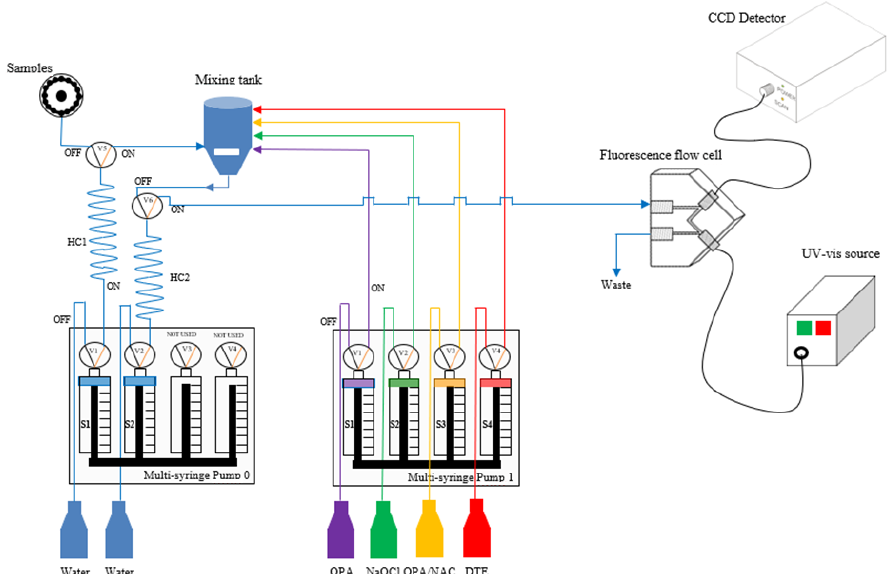
Figure 5. Schematic representation of the MSFIA manifold used for tropomyosin determination